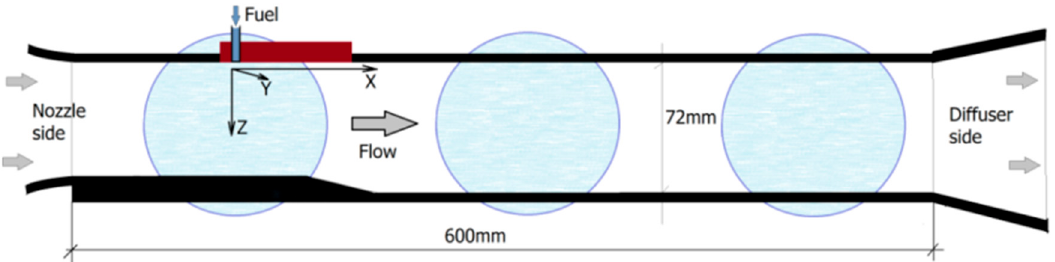
Figure 7. Schematics of the PWT-50H test section. The location of the plasma-injection modules is shown by a rectangle in the top wall.